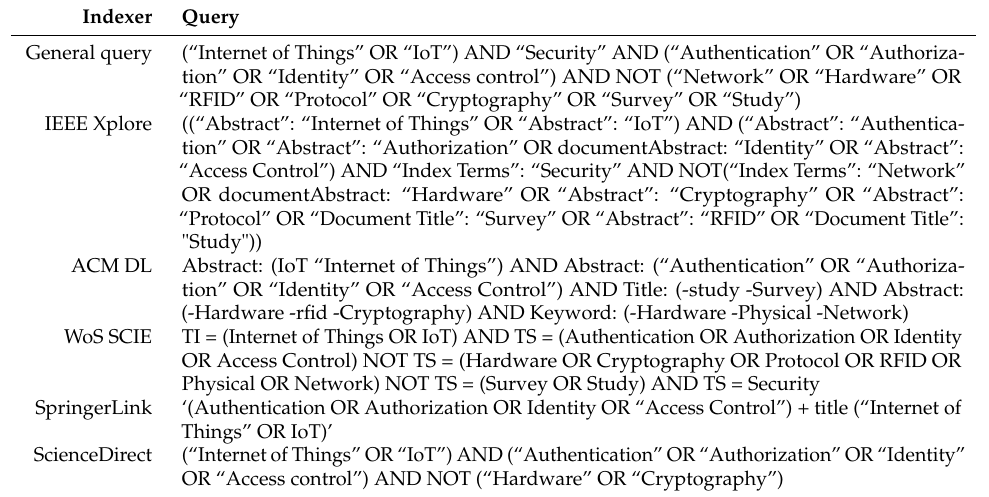
Table 2. Queries used for the search.